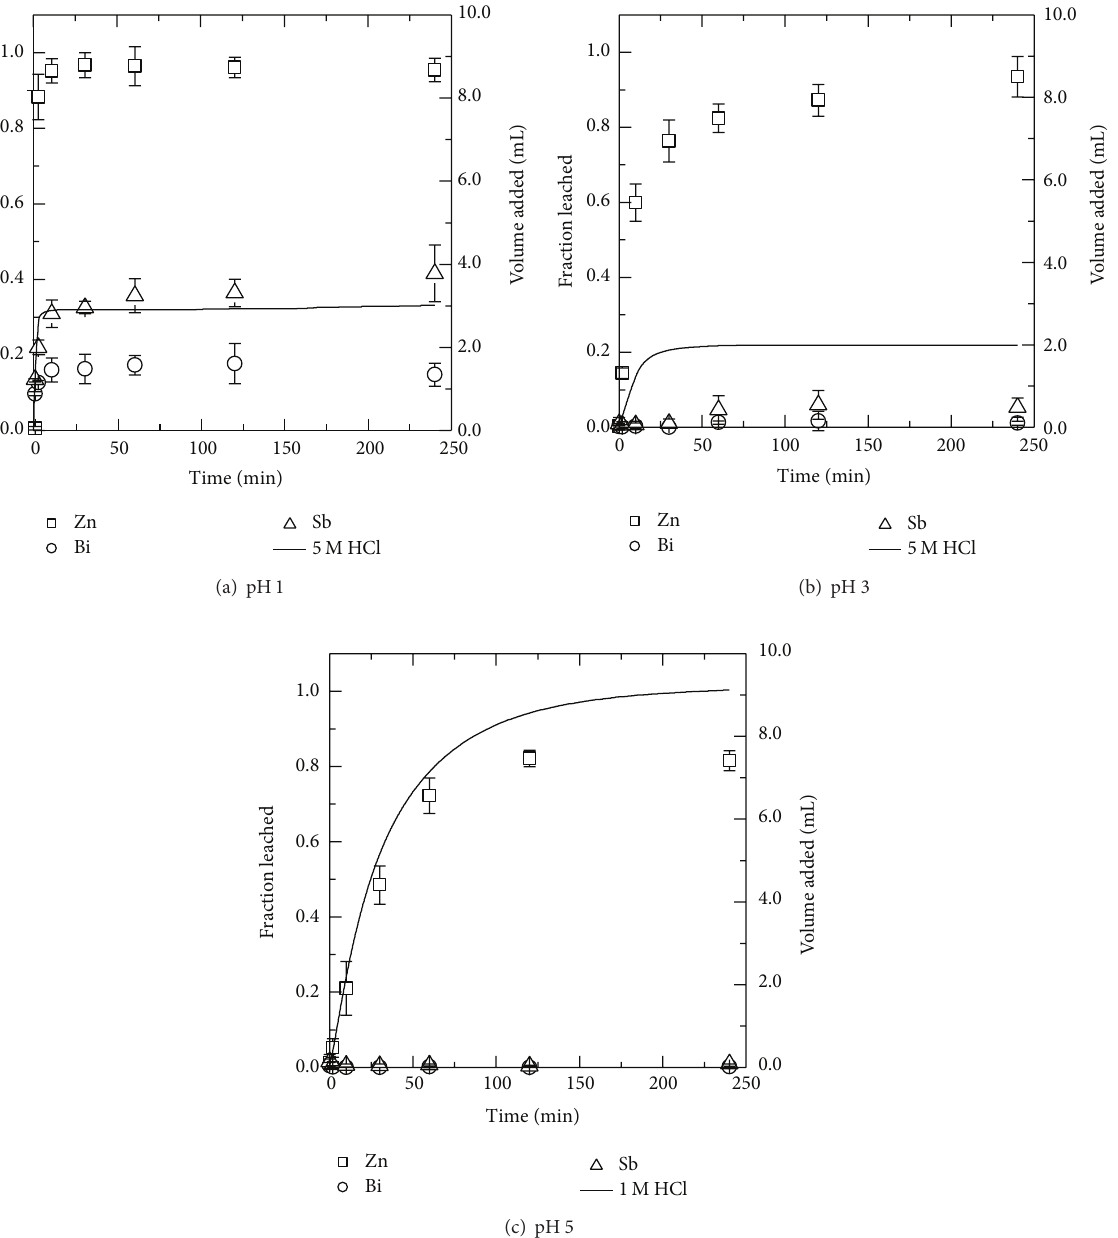
Figure 4: The leached fraction as given by the left ordinate for zinc ( ◻ ), bismuth ( I ), and antimony ( 󳵻 ) from MOV in (a) pH 1, (b) pH 3, and (c) pH 5 solutions. The volume of hydrochloric acid (HCl) added is shown as a solid black line corresponding to the right ordinate.